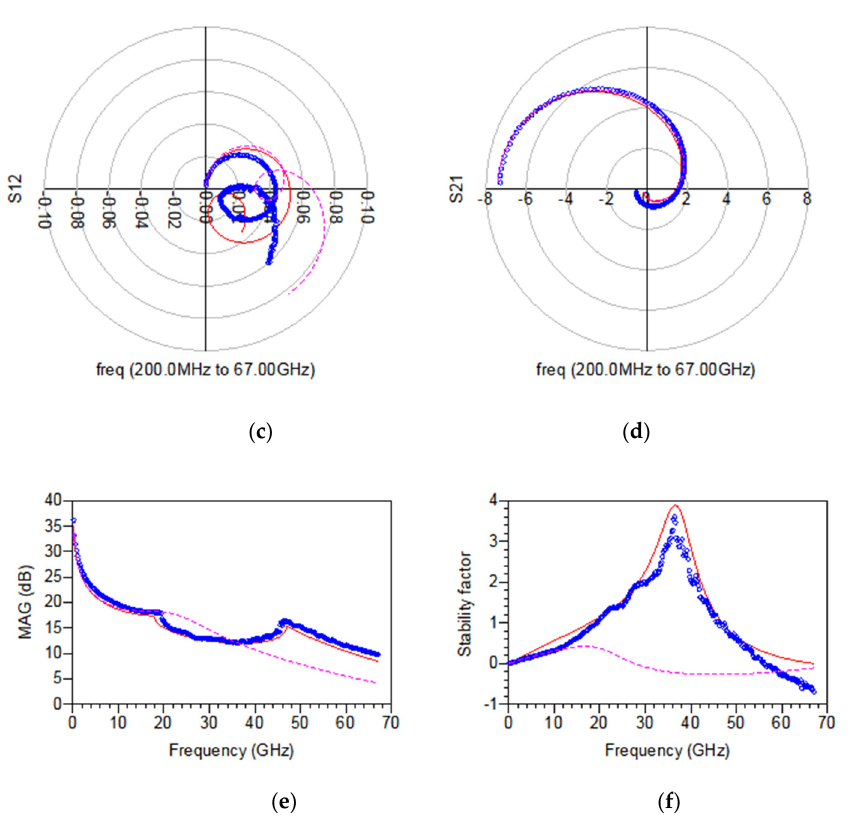
Figure 11. Comparison of ( a ) S11, ( b ) S22, ( c ) S12, ( d ) S22, ( e ) MSG/MAG, and ( f ) stability factor among the measurement (blue circle), the conventional model (pink dashed line), and the proposed model (red line) from 0.2 to 67 GHz under V ds = 28 V, V gs = − 1.6 V.